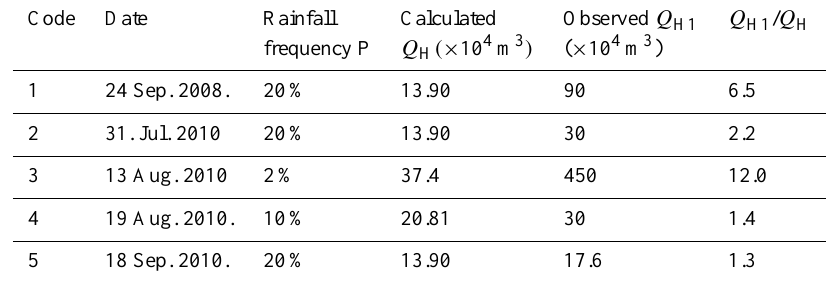
Table 4. A comparison between observed and calculated volumes of solid material of debris flows in the Wenjia catchment.